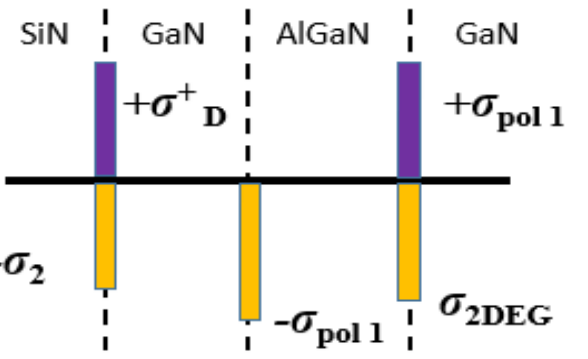
Figure 2. Polarization charges defined for GaN/AlGaN/GaN device in TCAD simulation.